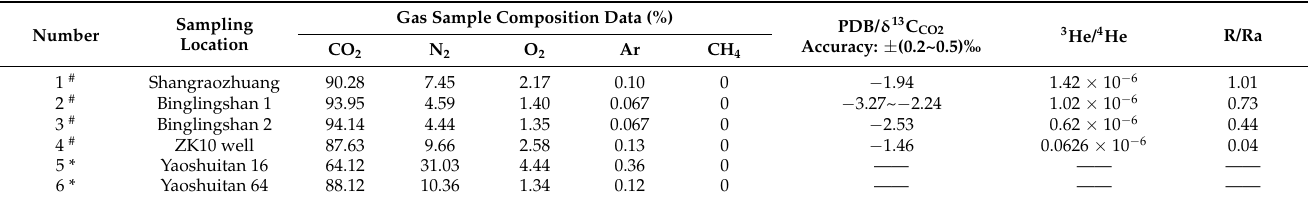
Table 3. Composition and content of gas phases in groundwater